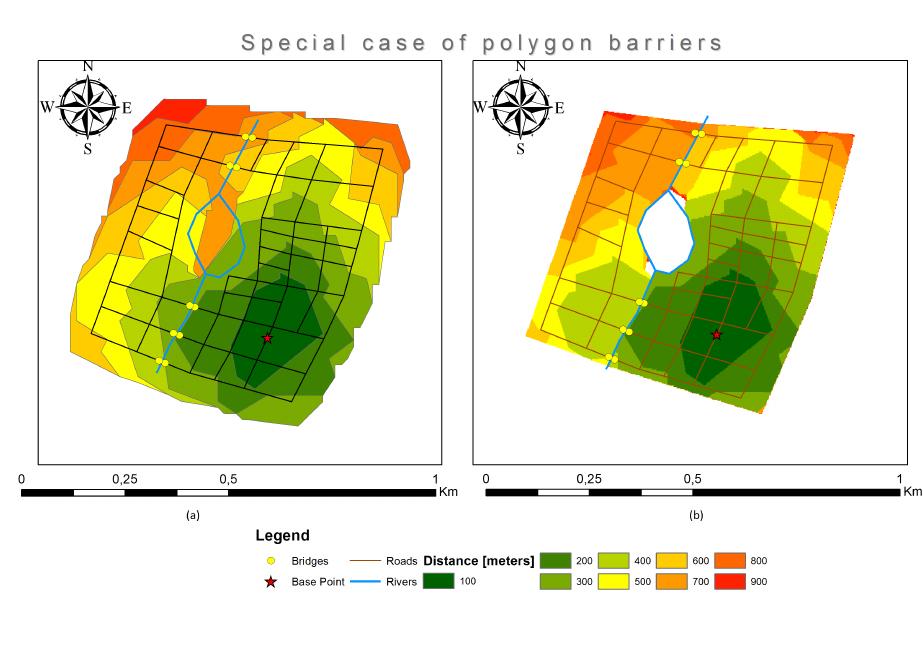
Figure 21. The results of an analysis for excluded areas: ( a ) ArcGIS network analysis; ( b ) proposed algorithm.